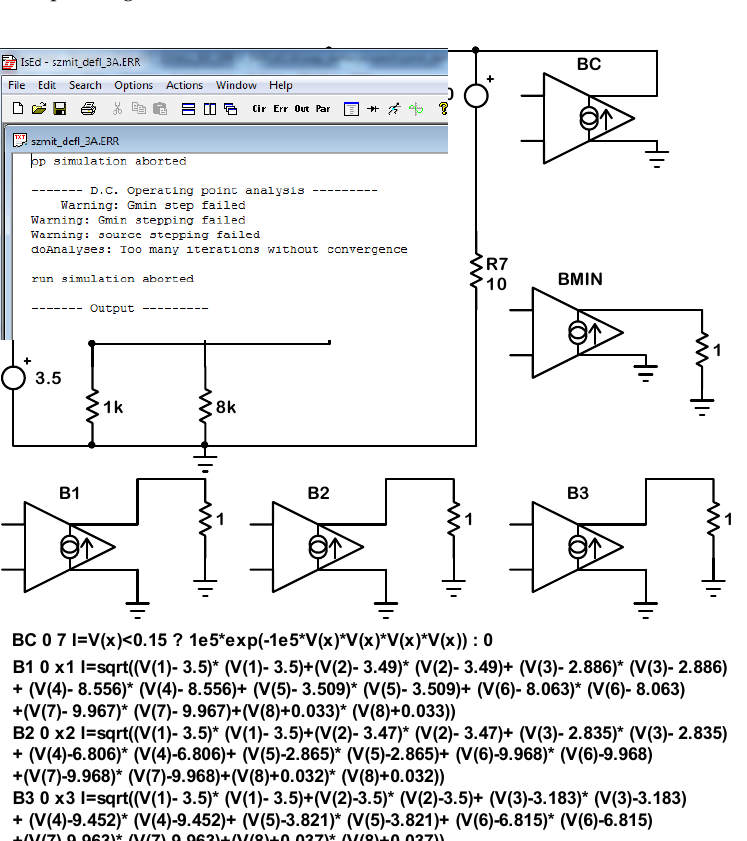
Figure 5. Modified, according to the idea of deflation, circuit shown in Figure 4 with the message of the divergent process ( k =